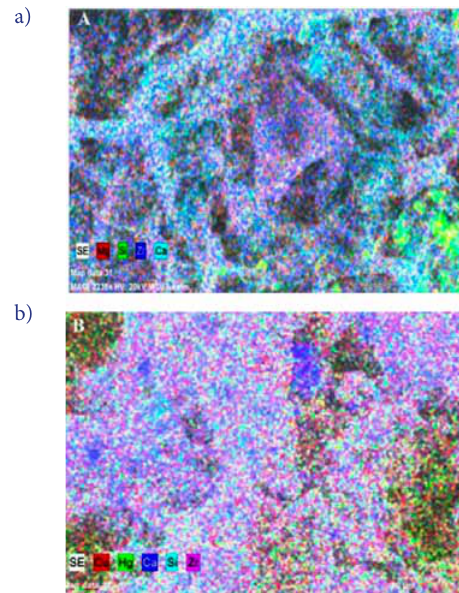
Fig. 3. (a) Element distributions of EDX analysis region before biosorption (b) Element distributions of EDX analysis region